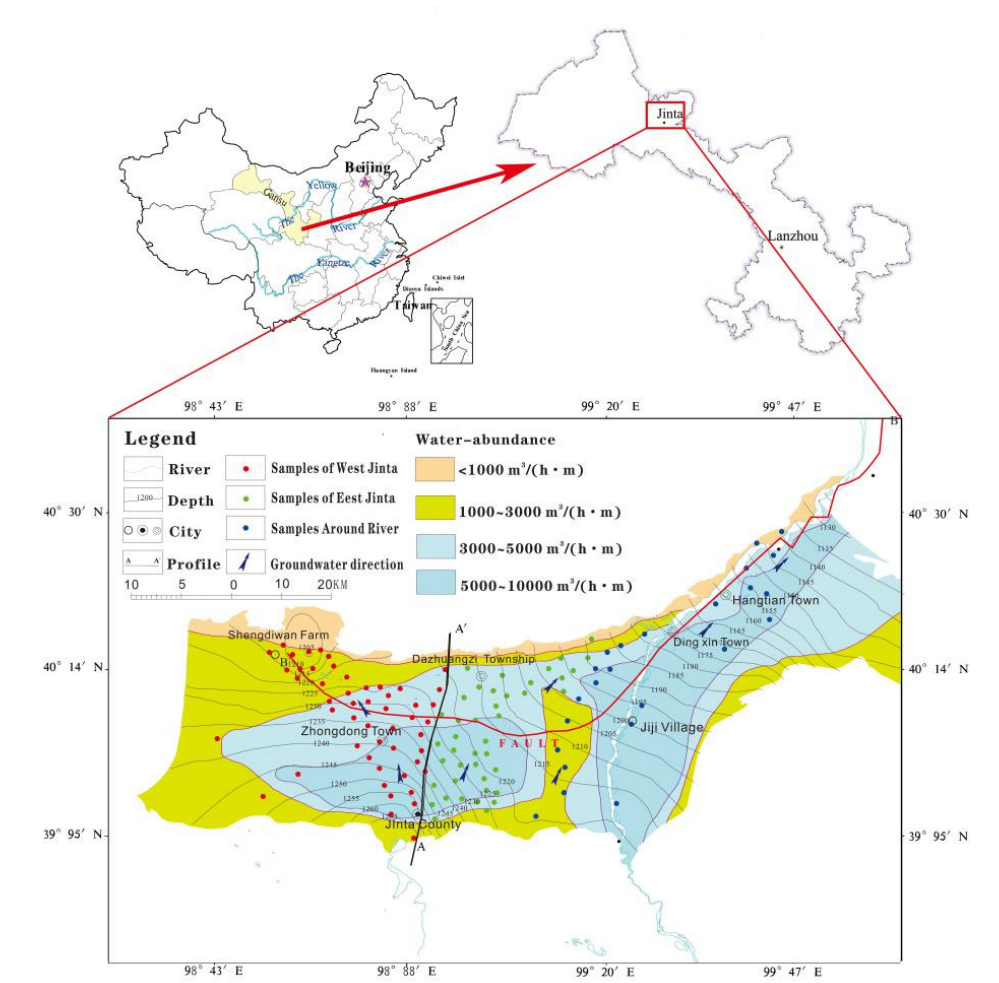
Figure 1. Map of the Jinta Basin within China and the locations of groundwater sampling points.